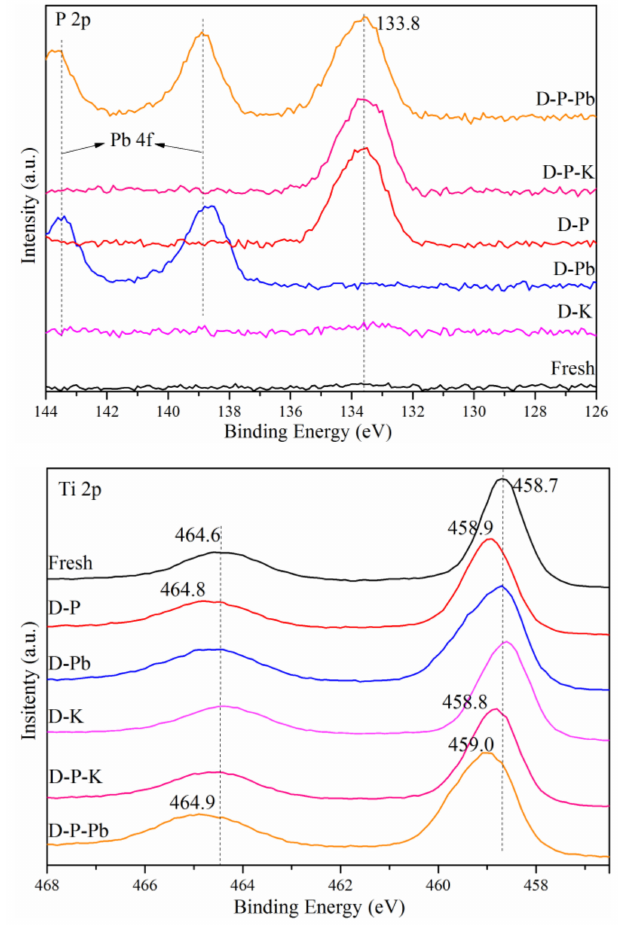
Figure 6. XPS spectra of the O 1s, V 2p 3 / 2 , P 2p and Ti 2p of fresh and poisoned